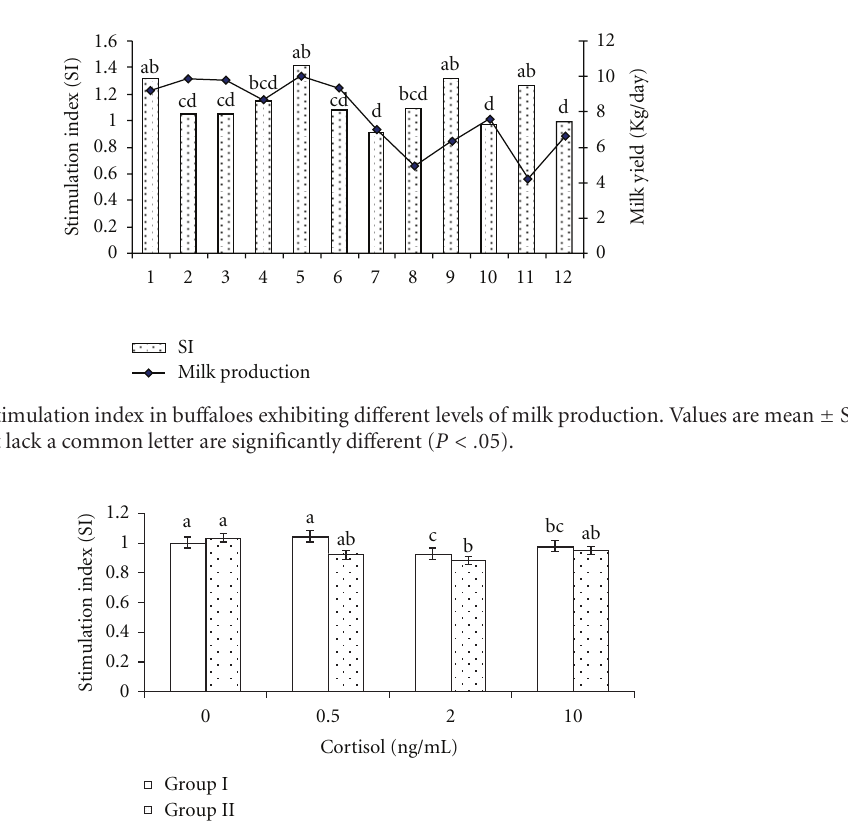
Figure 2: Mitogen-induced stimulation index at di ff erent levels of cortisol in di ff erent groups of bu ff aloes. Values are mean ± SEM. Bars with values in di ff erent groups that lack a common letter are significantly di ff erent ( P < . 05).